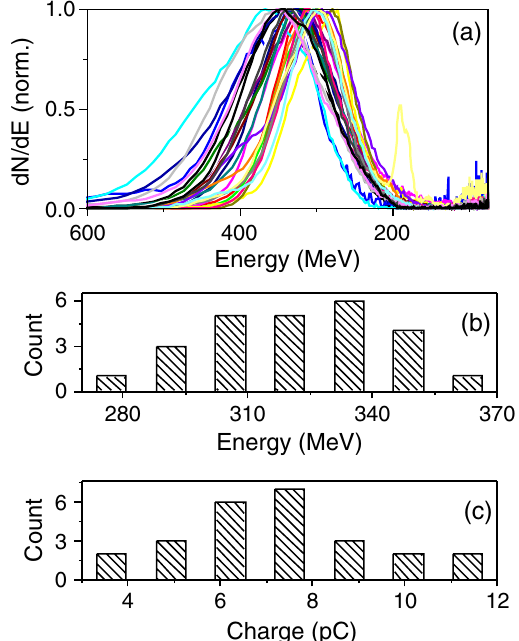
FIG. 8. (a) Energy spectra for individual shots, (b) statistics of energy corresponding to the spectral peak, and (c) statistics of charge over the series of 25 shots of Fig. 7. The energy histogram shows seven bins between 270 and 340 MeV (bin size (cid:1) E (cid:5) 14 MeV ). The charge histogram shows seven bins between 3 and 12 pC ( (cid:1) Q (cid:5) 1 : 3 pC ).